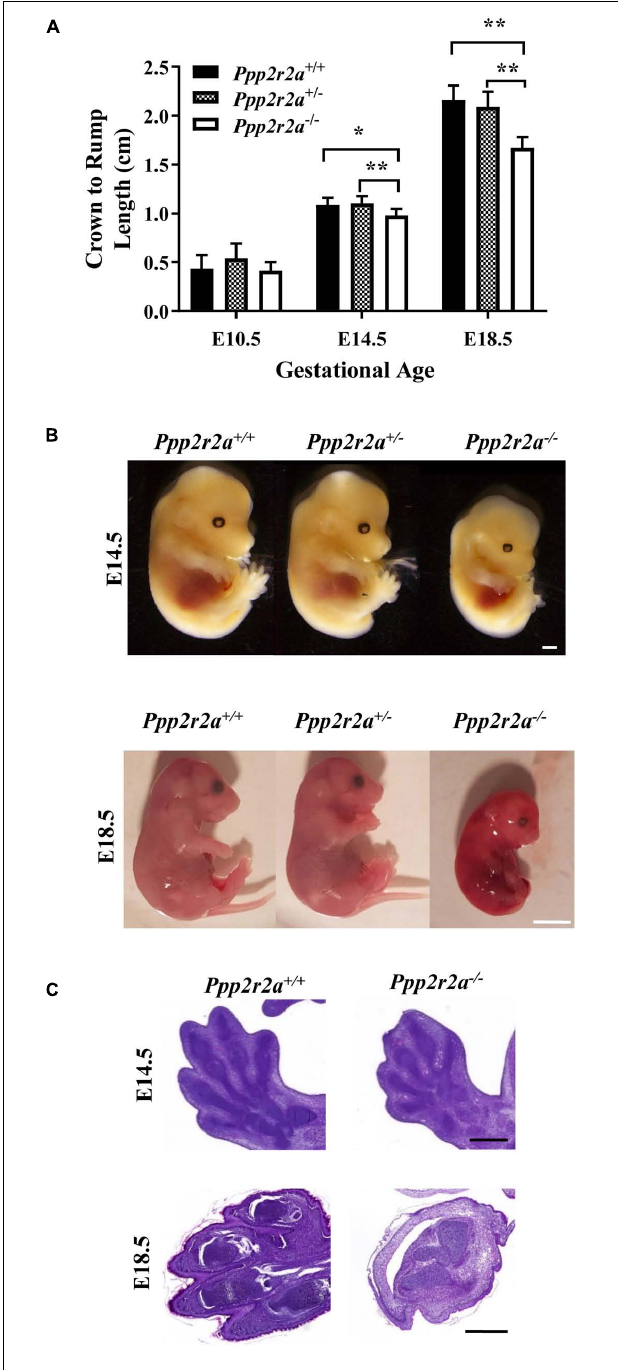
FIGURE 2 | Ppp2r2a knockout embryos are small with epidermal hemorrhaging and syndactyly. (A) Crown-to-rump measurements of embryos at three developmental stages: embryonic day 10.5 (E10.5) ( n = 5 per genotype), E14.5 ( n = 7) and E18.5 ( n = 7). * p < 0.05, ** p < 0.01, unpaired two-tailed t -test. (B) Representative photographs of E14.5 and E18.5 embryos. Ppp2r2a − / − embryos display reduced size, syndactyly and gross epidermal hemorrhaging (E18.5). E14.5 scale bar = 0.5 mm; E18.5 scale bar = 5 mm (C) . H&E staining of E14.5 and E18.5 embryo sections demonstrates syndactyly of the hind limbs in Ppp2r2a − / − embryos. Scale bars = 0.5